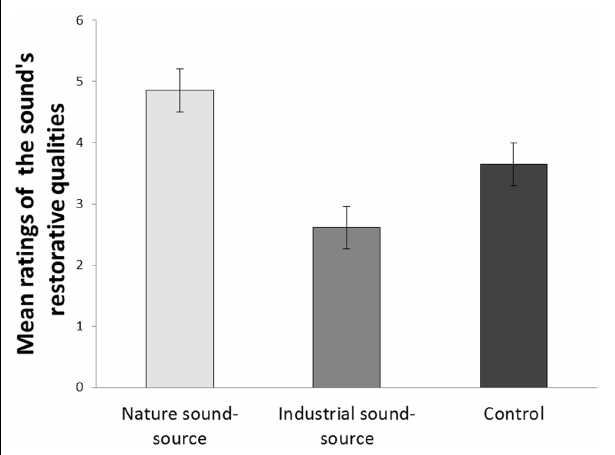
FIGURE 1 | Mean subjective ratings of the sound’s restorative qualities across the three sound-source conditions. Error bars represent standard error of